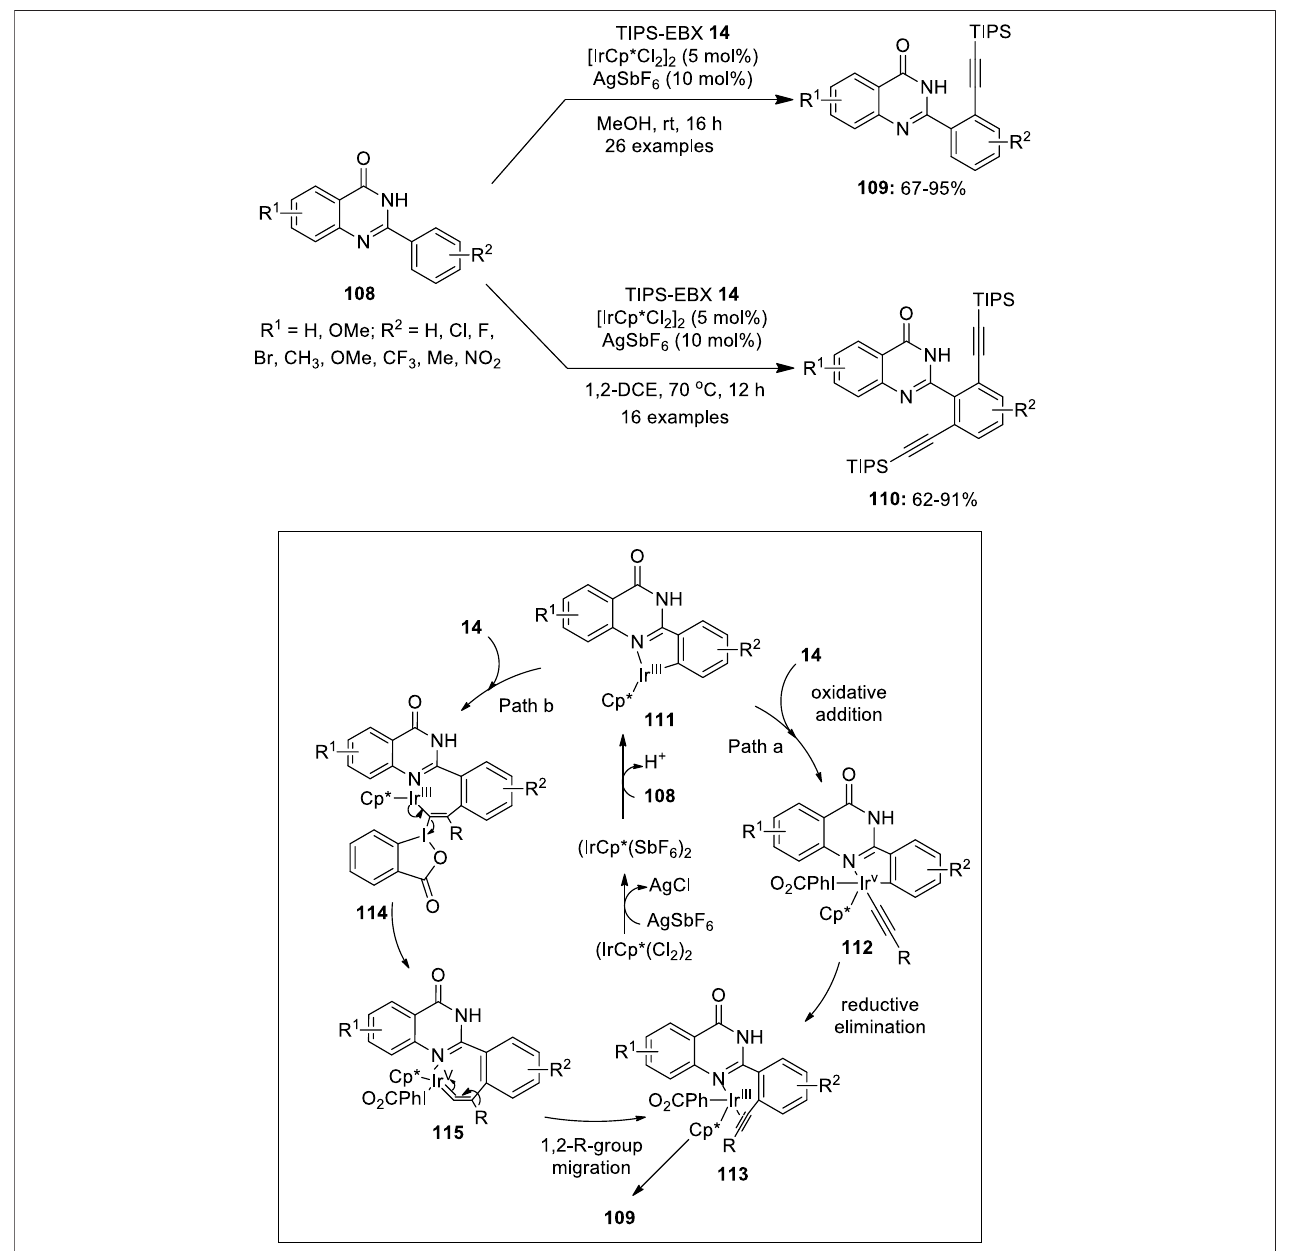
FIGURE 22 | Iridium-catalyzed C – H alkynylation of 2-(hetero)arylquinazolin-4-ones 108 using TIPS-EBX 14 as an alkynylating reagent.